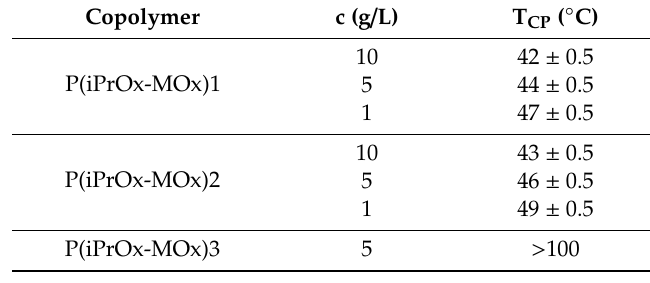
Figure 3. Transmittance-temperature dependence during heating (filled signs) and cooling (empty signs) of aqueous solutions of copolymers (c = 5 g/L). Table 2. T CP values of copolymers at different concentrations in water .